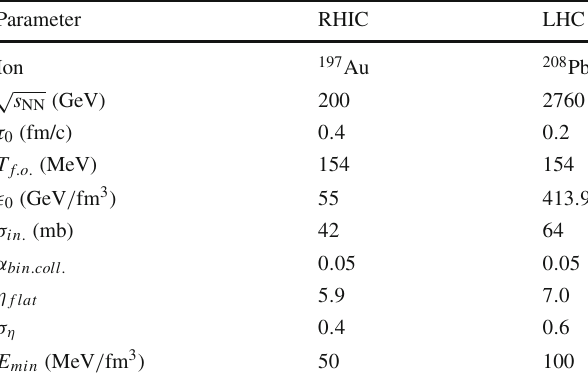
Table 1 List of the main parameters used in the numerical simulations Parameter